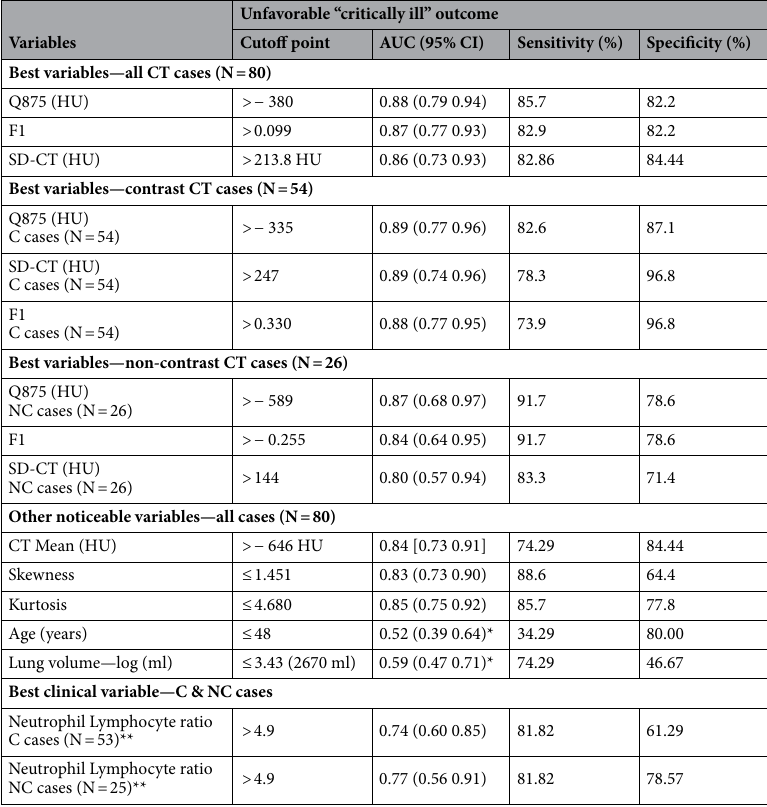
Combined length‑of‑stay (LOS) and in‑hospital mortality assessment. For SD-CT, Q875 and F1 predictors, the patient cohort was stratified in two groups using optimal cutoff points for combined contrast and non-contrast studies found in the univariate analysis: SD-CT ≥ 213.8 HU, Q875 > − 380 HU and F1 > − 0.099. Using Q875 feature (see Fig. 3—dashed lines) the cumulative incidence LOS at 30 days was: 89% (80%, 98%) for low Q875 group compared to 40% (24%, 56%) for high Q875 group. the Q875 based cumulative incidence for Death at 30 days was: 2.4% (0%, 7%) for low Q875 group 1 compared to 21% (8%, 34%) for high Q875 group 2. Both inter-group differences in cumulative incidences for LOS (P < 0.0001) and Death (P = 0.027) were significant. Using F1 feature (Fig. 3—solid lines) the cumulative incidence LOS at 30 days was: 81% (69% 93%) for low F1 group compared to 47% (31% 63%) for high F1 group. The F1-based cumulative incidence for Death at 30 days was: 4.6% (0% 11%) for low F1 group 1 compared to 19% (6% 31%) for high F1 group 2. Inter-group difference in cumulative incidence for LOS (P < 0.0001) was significant while those for Death did not reach significance (P = 0.09). Similarly, the patients of the low SD-CT group had a probability of being discharged before or at 30 days of 89.7% (80.4% 99.1%) compared to 36.8% (20.9% 52.7%) for the high SD-CT group (P < 0.0001) and a mortal- ity risk at 30 days of 2.3% (0.0% 6.6%) (P = 0.022) compared to 22.4% (8.7% 36.0%) for the high SD-CT group (P = 0.022). Multivariate analysis of patient length‑of‑stay (LOS) with competing risks. The prediction of the hospital length-of-stay (event: hospital discharge) in presence of a competing risk (death) was further inves- tigated in a multivariate framework using the Fine-Gray regression (FGR) for competing risks 18 . Two multivari- ate models FGR-F1 and FGR-Q875 were selected using the stepwise backward variable selection adapted to the FGR models and further described in the statistical method section. Each of these models included the covari- ates: Contrast, Age and NLR with either F1 (FGR-F1 model) or Q875 (FGR-Q875 model). See Table 3. For per- formance comparison, the Reference model (no covariate) and the FGR-1 model without CT density variables (with only Age, NLR and Contrast) were also computed. See Supplementary Fig. S4. Both models FGR-F1 and FGR-Q875 revealed negative coefficients for F1, Q875, Age and NLR indicating that increased values of these covariates would decrease the incidence of the hospital discharge and thus would increase the hospital length of stay. Conversely, in both models the coefficients for Contrast (enhanced CT = 1) were positive, indicating an